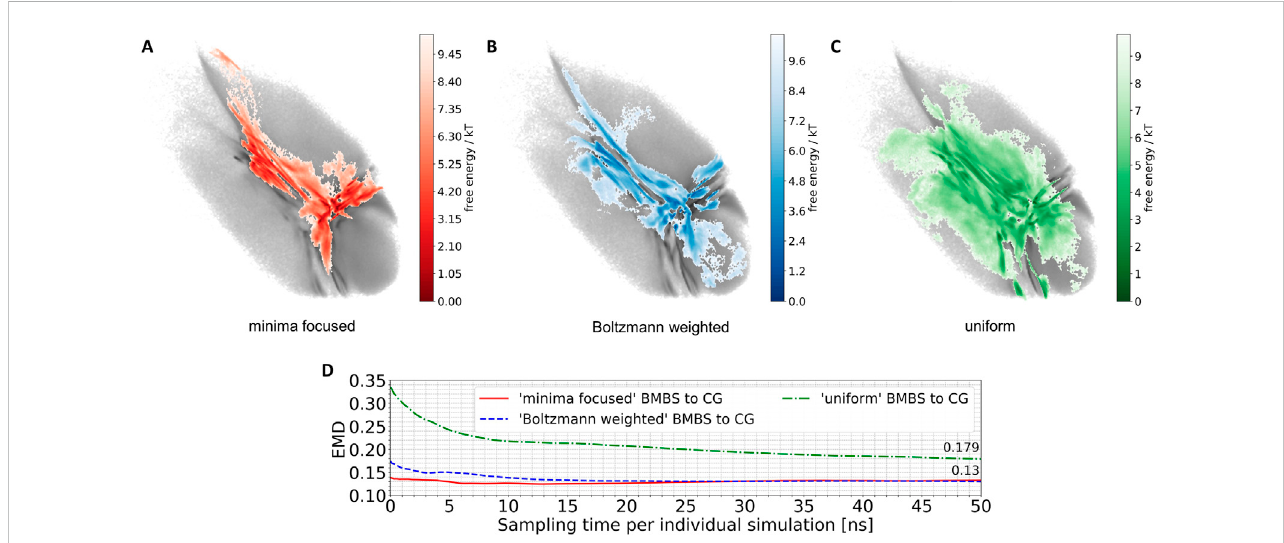
FIGURE 3 Projections of 50 atomistic simulations obtained using BMBS with minima-focused (A) , Boltzmann-weighted (B) and uniform (C) seedings. (D) EMD values between CG and BMBS projections as a function of sampling time. Colors of the projections and EMDs lines correspond to the coloring in Figure